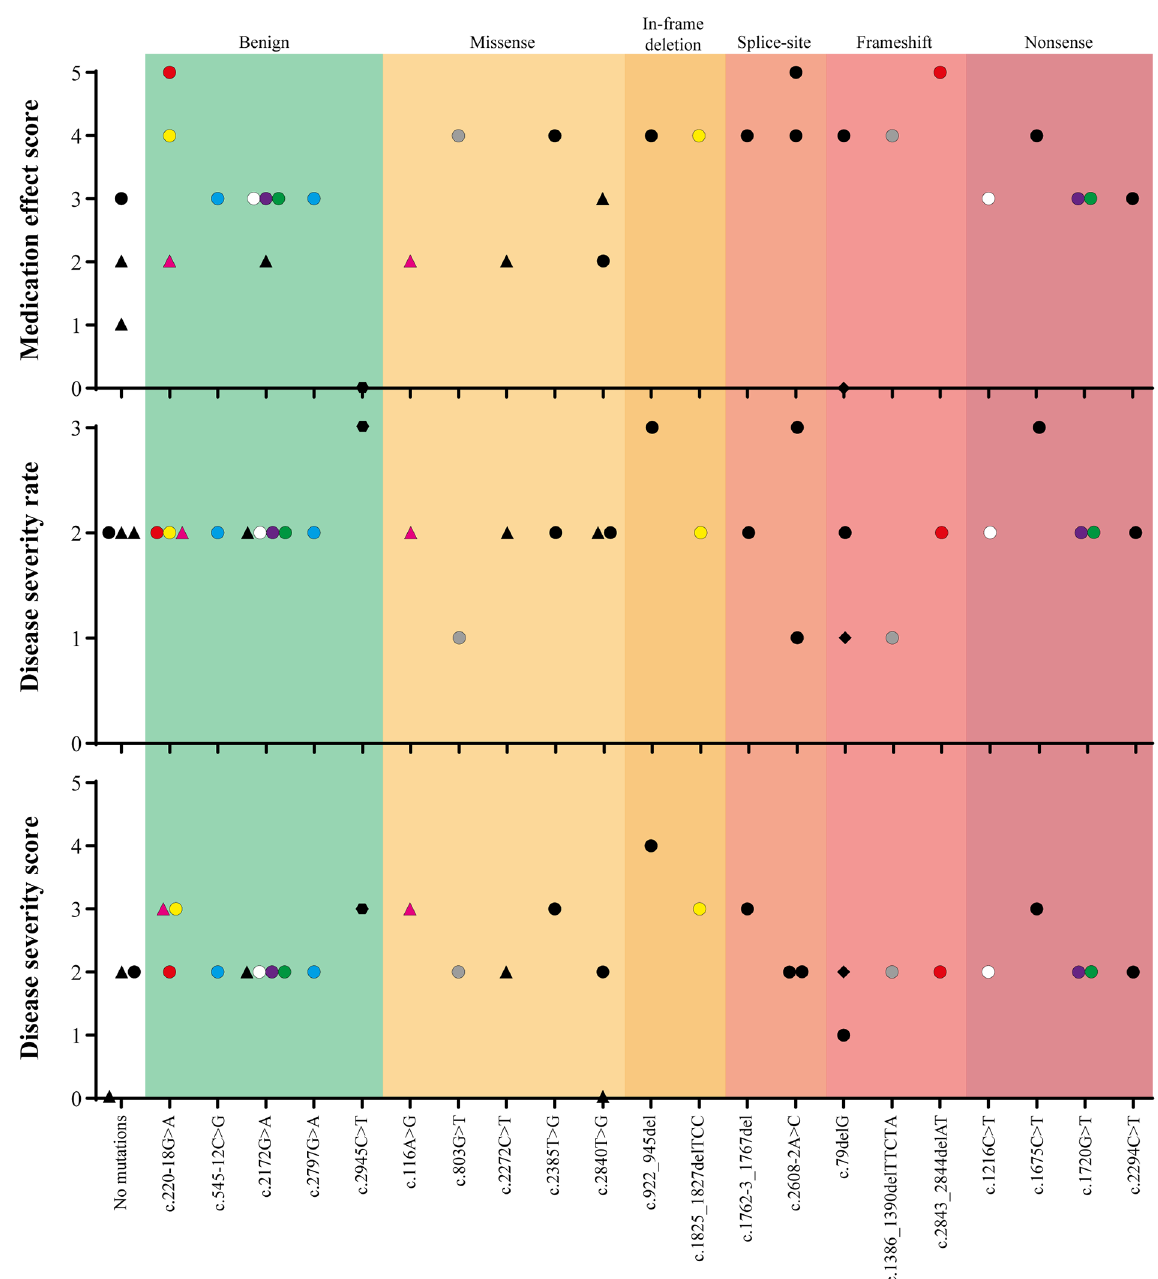
Fig 3. Medication effect (1–5), disease severity (mild–severe) and disease severity(1–5) scores sorted by mutation type. Medicationeffect and diseaseseverity score (Top and bottom), a score of 1 = bad, 2 = acceptable, 3 = good, 4 = very good or 5 = excellent.Disease severity rate (Middle), a score of 1 = severe, 2 = moderate and 3 = mild. A score of 0 corresponds to patient’s lack of answer to a particular category. The type of ATP2A2 mutation is shown on the x-axis, and they are sorted into seven categories: No mutations, benign,missense, in-frame deletion,splice-site,frameshift and nonsensemutations. ● represent patients receivingsystemic treatment; ▲ represents patients receivingtopical treatment; ◆ represent patients receivingno treatment and ´ represent patients who have received laser treatment. The different colouredpoints represent the patients with two ATP2A2 variants. Points with the same colours are variants in the same patient.